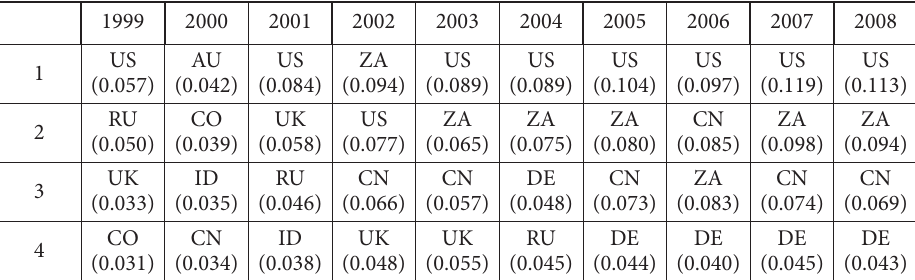
Table 5. Trade hubs’ betweenness centrality in